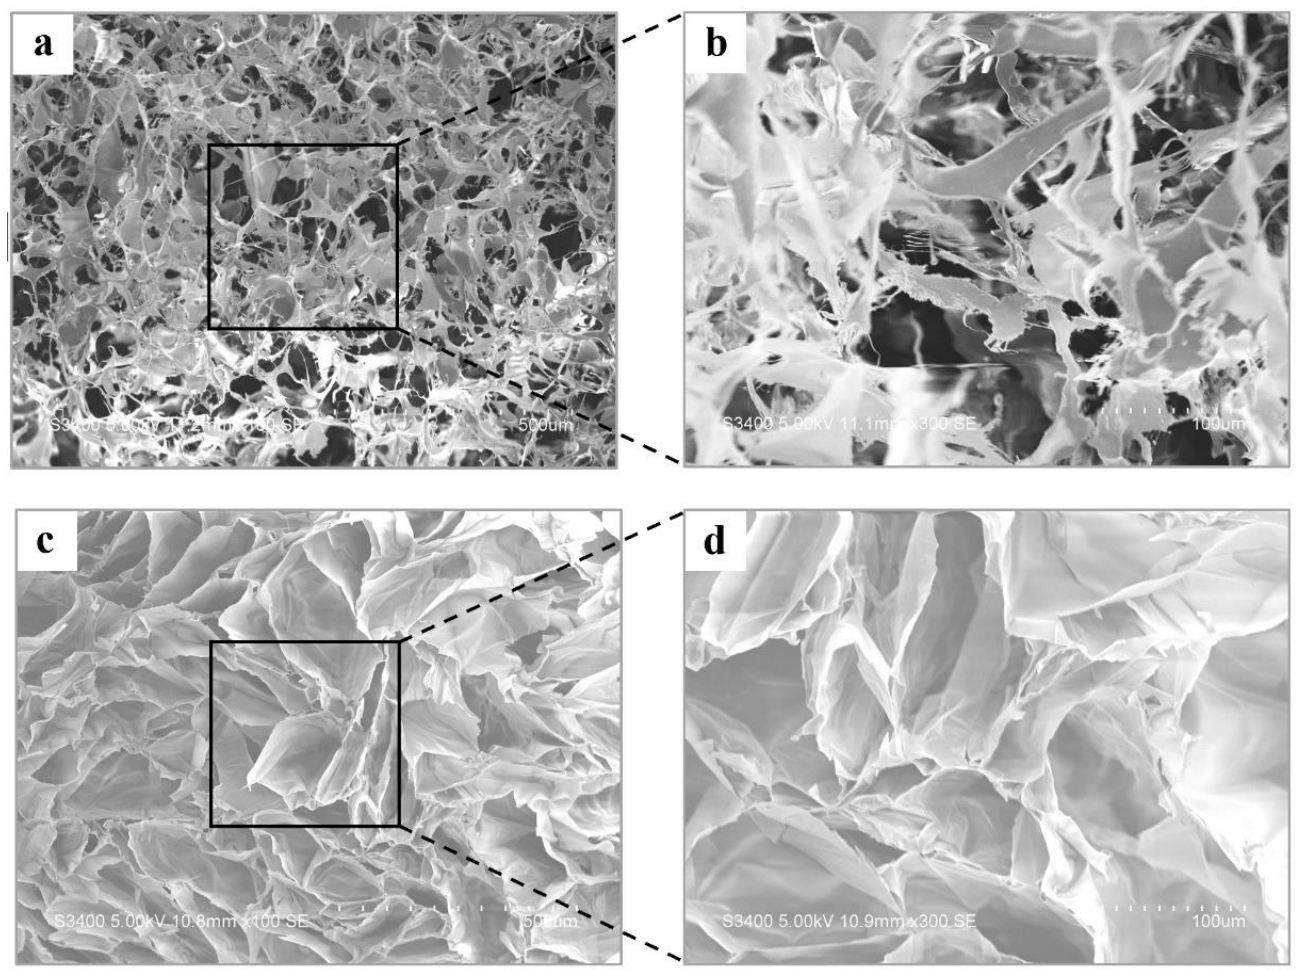
Figure 1. ( a , b ) Scanning electron microscopy (SEM) of 0.5 wt % GMG; ( c , d ) SEM of GMGH. The a , c scale bar = 500 μm, and the b , d scale bar = 100 μm .